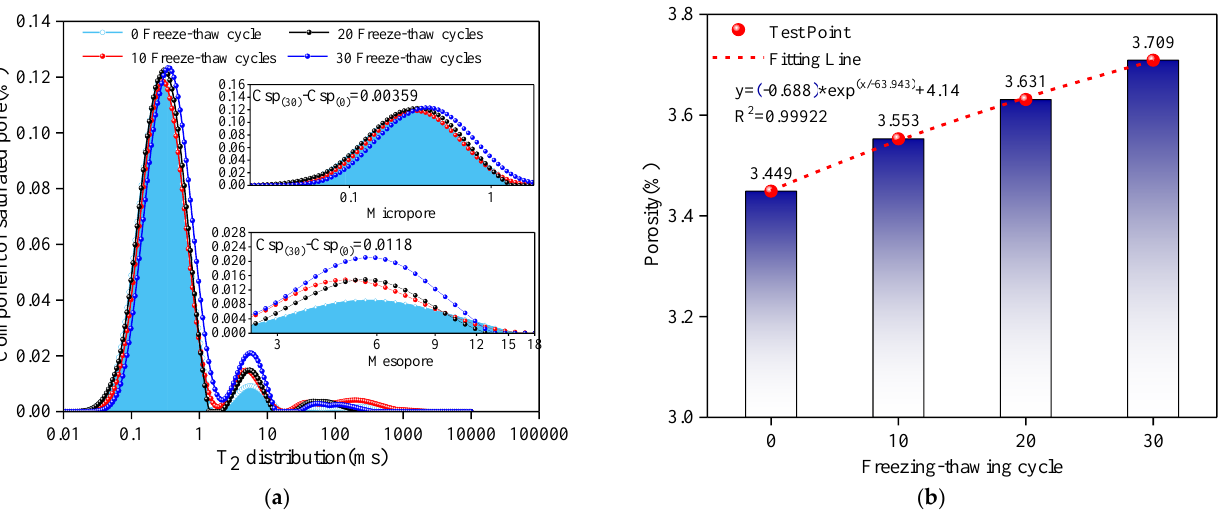
Figure 5. The effect of freezing-thaw cycles on microscopic pore structure. ( a ) Relaxation distribution; ( b ) porosity.